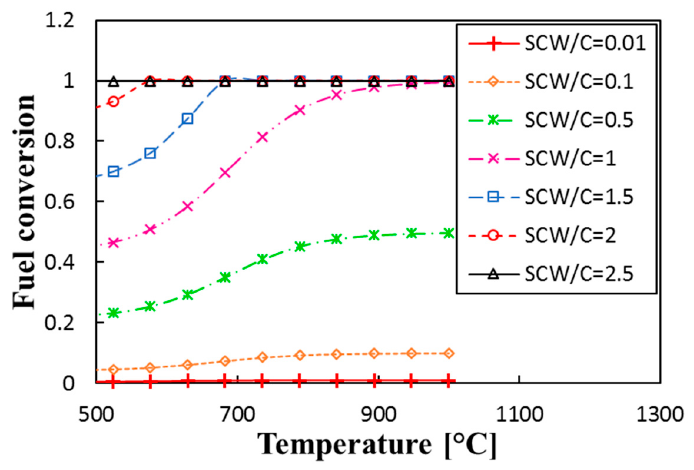
Figure 8. Variation of the carbon (fuel) conversion extent with temperature, for various values of SCW/C ratio in reactor R